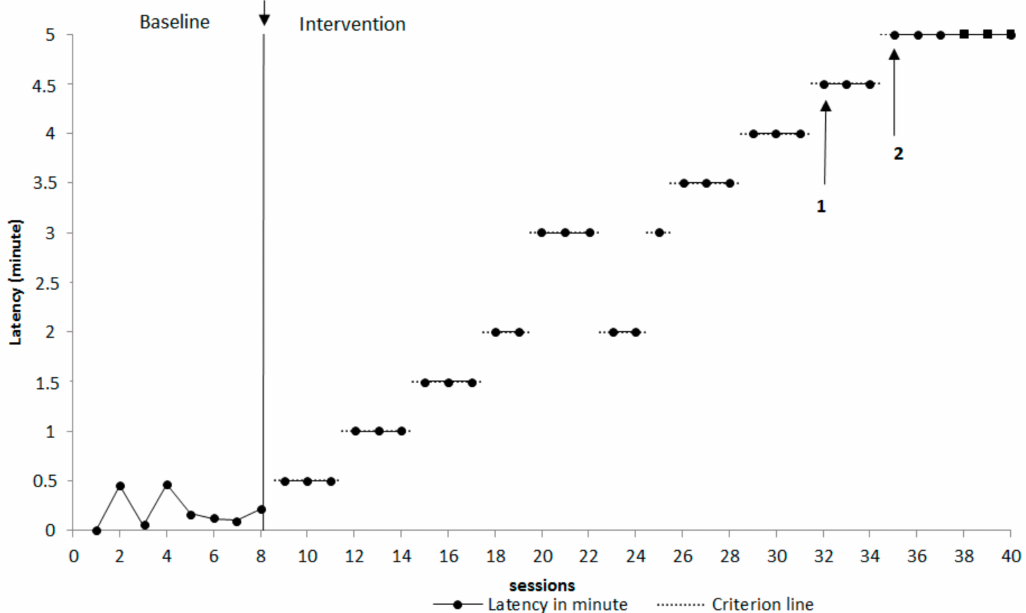
Figure 2. Latency in minutes to engage in stereotyped vocal behaviour during baseline sessions and interventions. Note: Arrows with numbers 1 and 2 indicate fading steps of the green card stimulus (Arrow #1 = fading sessions 32–34; Arrow #2 = no-card sessions 35–40). The arrow between the BL and intervention indicates discrimination training between the baseline and the intervention. Also, the dependent variable is the latency in minute, hence the time spent between the end of the given stimulus (“now you can play”) and the beginning of the stereotypy. The horizontal dotted lines represent the pre-established criteria in order to provide the reinforcement (access to the green card condition). The predetermined criterion is gradually